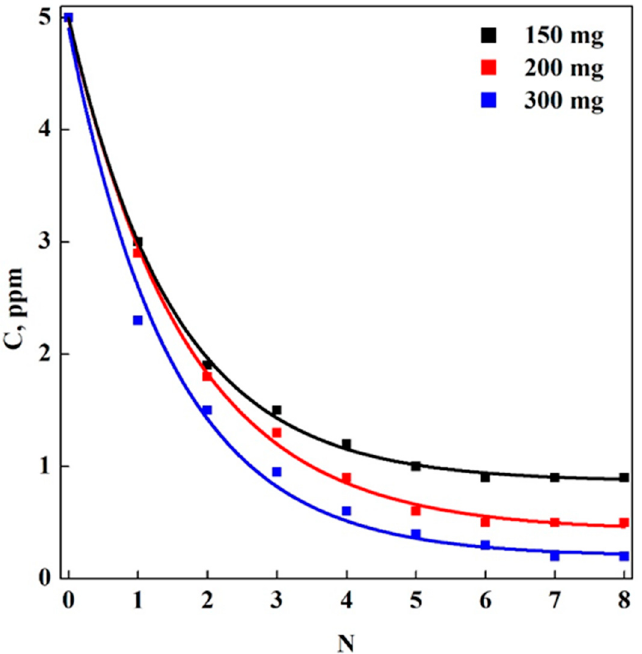
Figure 5. Adsorption kinetics of aerogel samples analyzed in the experiments of Set A (Aerogels) performing a multi-step adsorption (T = 25 °C, flow rate = 0.1 mL/min) and using three different amounts of aerogels: 150 mg (black line), 200 mg (red line) and 300 mg (blue line).